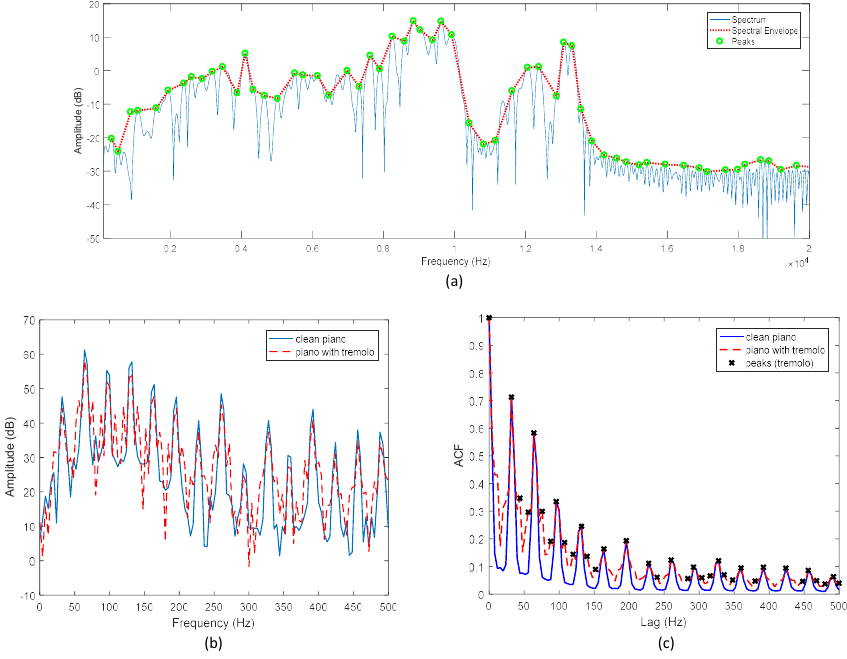
Figure 1. ( a ) Harmonic peaks selected by spectral envelope estimation vocoder (SEEVOC) peak-picking routine for a song in the database, ( b ) short-time Fourier transforms of a C major chord played by a piano with and without a tremolo effect, and ( c ) their corresponding autocorrelations, R FF